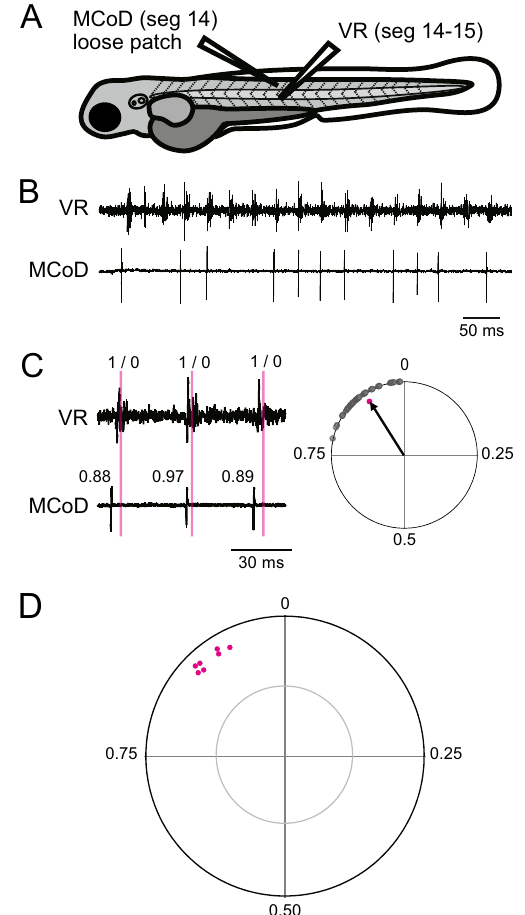
Figure 2. Firing pattern of MCoD neurons during spontaneously occurring fictive slow swimming. ( A ) A schematic illustration of the simultaneous recordings of an MCoD neuron (loose-patch) and ventral root (VR). ( B ) An example of the recording during spontaneously occurring fictive slow swimming. ( C ) A close-up view of two swim cycles. For the phase analysis of spike timings, the middle time point of a VR activity was assigned a phase value of 0, and that of the next VR activity was assigned a phase value of 1. The right panel shows a circular plot of 30 randomly selected spikes relative to VR activity during fictive swimming. The direction of the vector (arrow) shows the mean of the phase value, and the length of the vector shows the strength of the rhythmicity. ( D ) A circular plot showing the spike timing of MCoD neurons (n = 7). The grey circle line marks the 5% significance